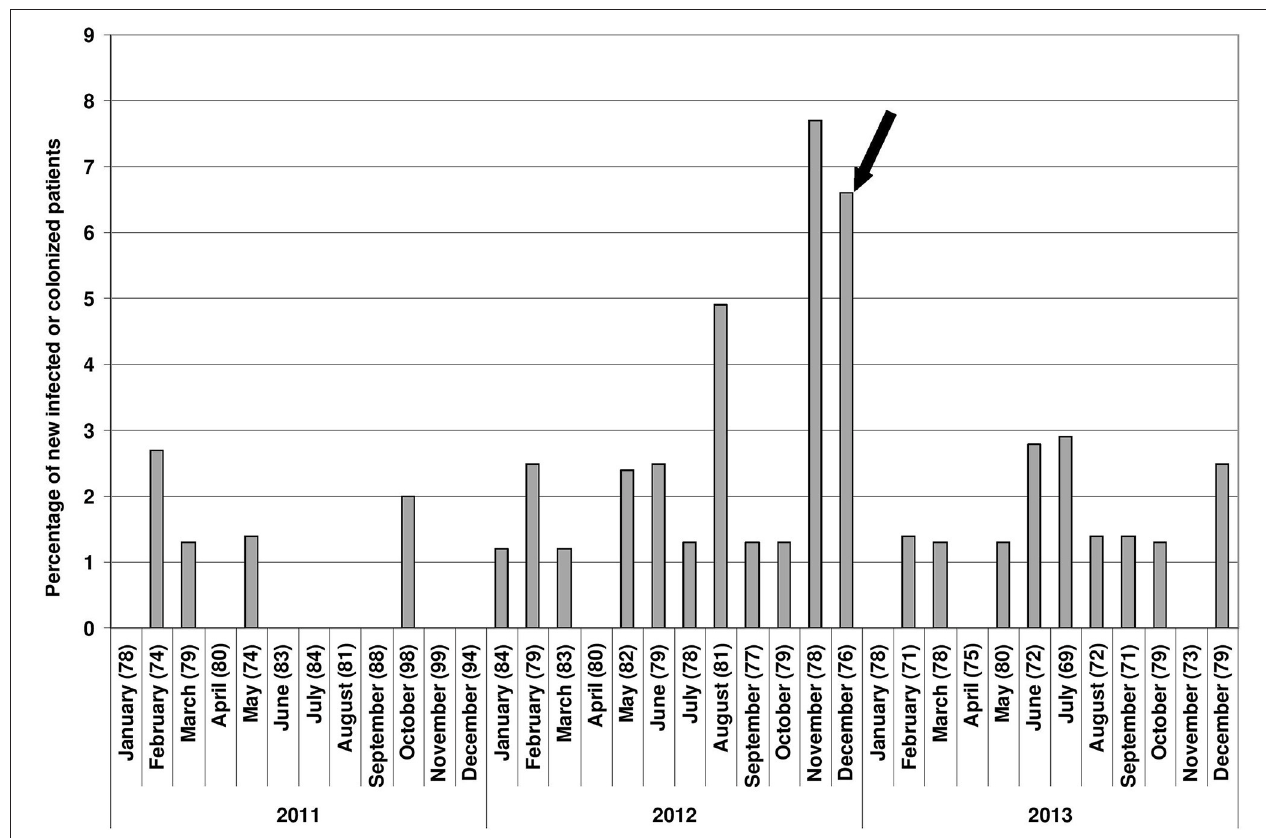
FIGURE 1 | Epicurve with all samples of E. cloacae for newly infected or colonized patients between January 2011 and December 2013. Numbers in parenthesis are the numbers of newly hospitalized patients in the Hematology ward each month. Black arrow: implementation of the bleach-based disinfection programme after complete cleaning of the